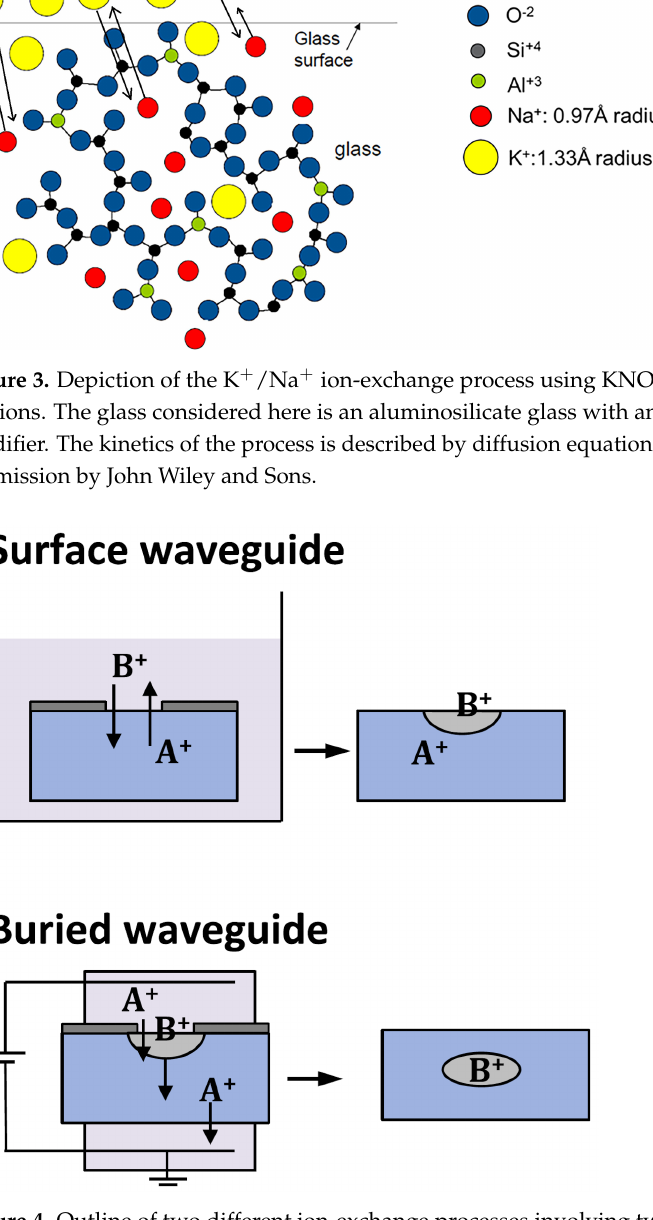
Figure 4. Outline of two different ion-exchange processes involving two ions A and B (e.g., K + and Na + , respectively): the upper drawing refers to a purely thermal diffusion, that produces a surface waveguide. The bottom drawing indicates a field-assisted diffusion, that leads to a buried waveguide. Reproduced with modifications from [25] with permission by